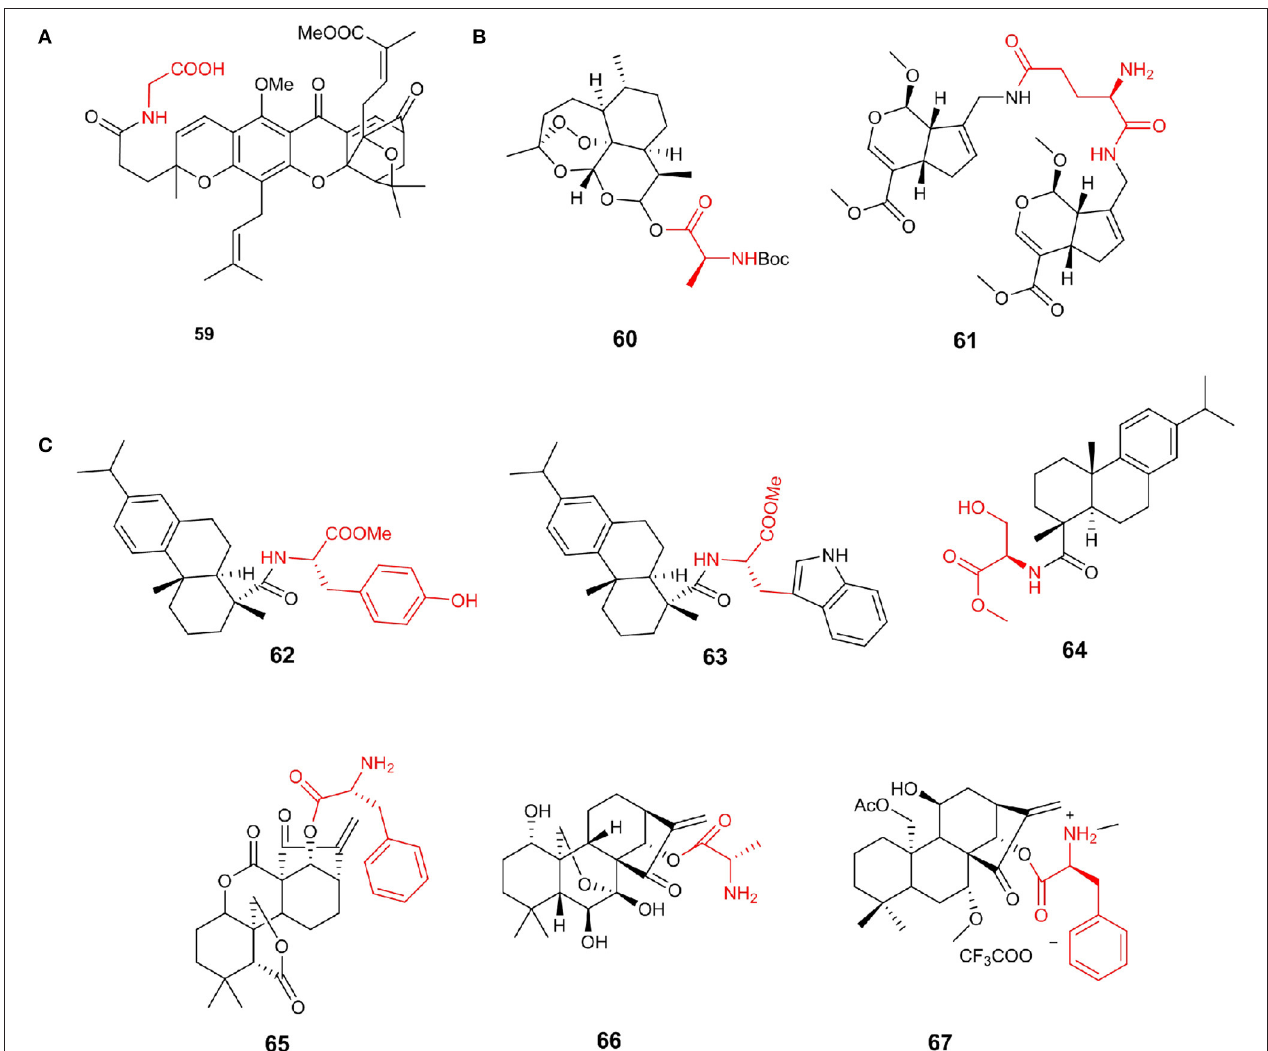
FIGURE 8 | (A) Gambogic acid amino acid derivatives. (B) Sesquiterpenes amino acid derivative. (C) Diterpenes amino acid